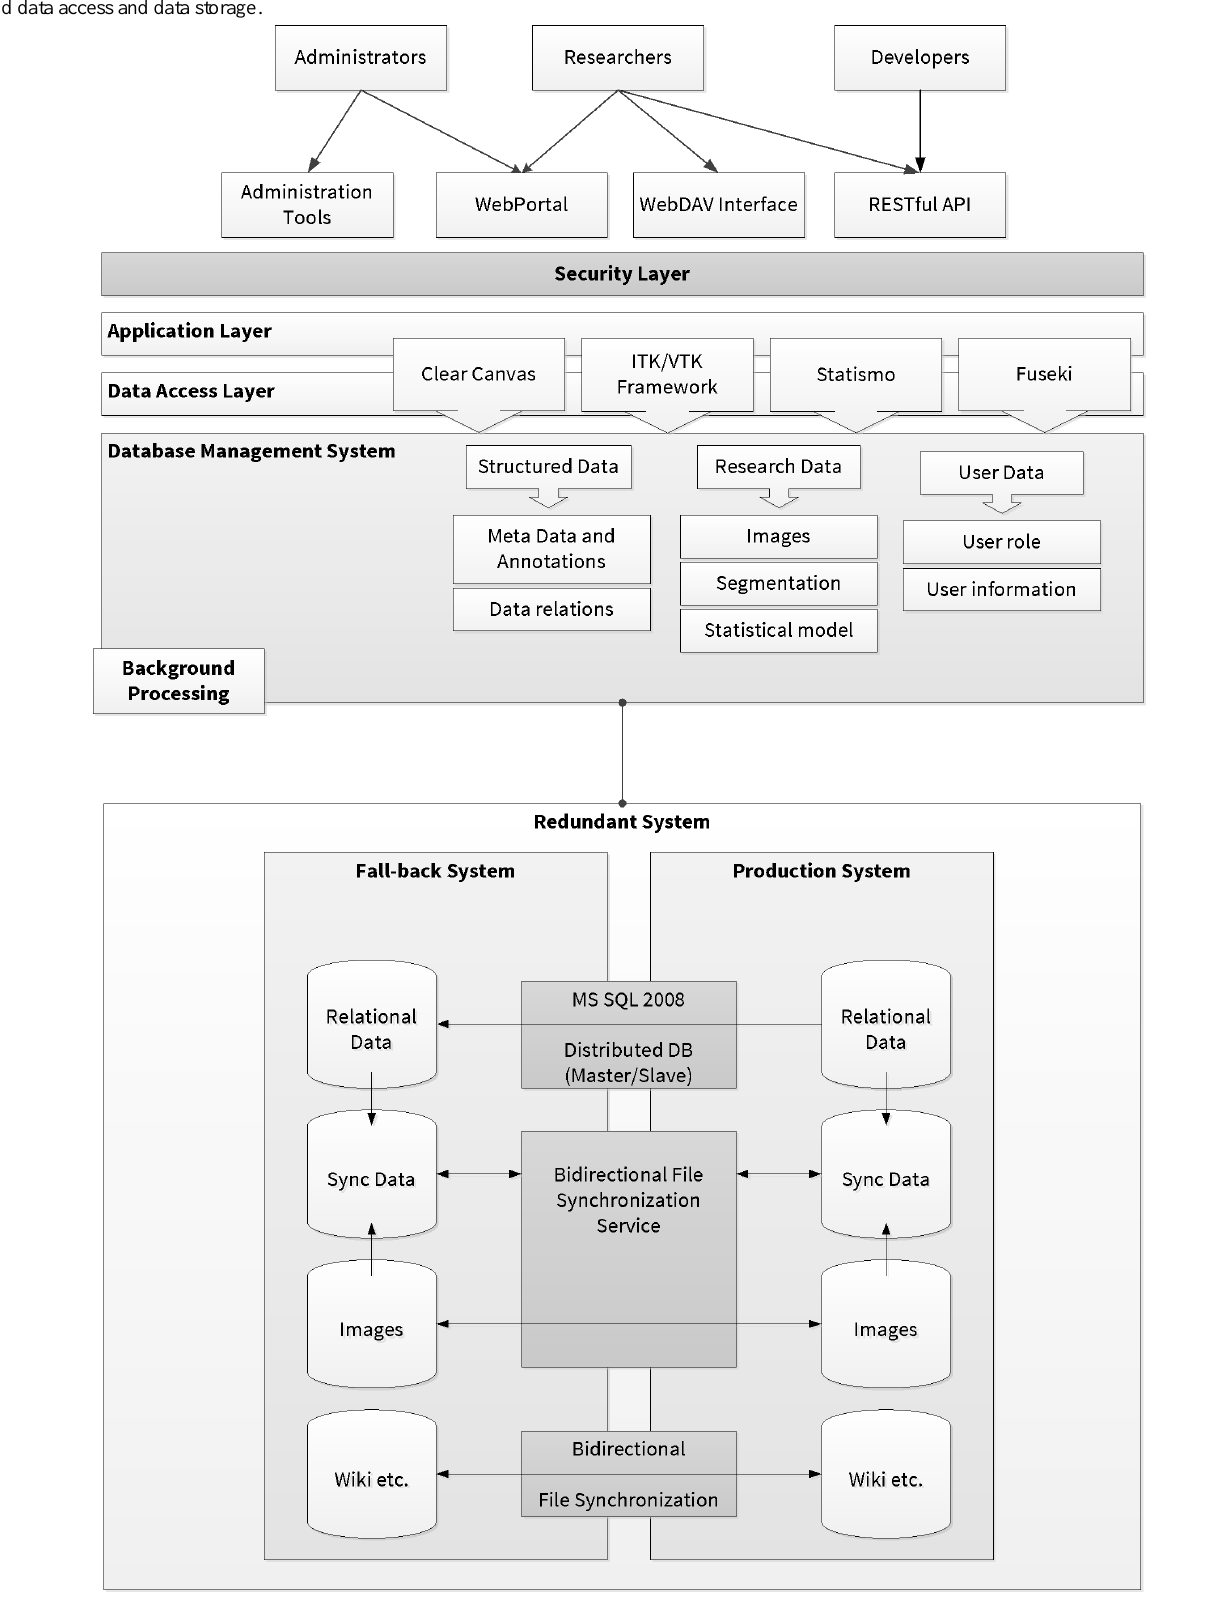
Figure 1. Schematics of the multitier architecture of the VSD, which consists of different types of interfaces, an application logic and security layer, and data access and data